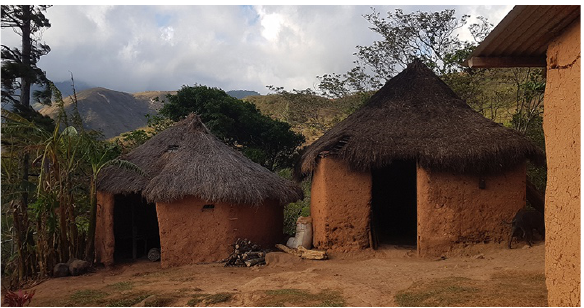
Figure 17. Buglé houses at Piedra Grande.